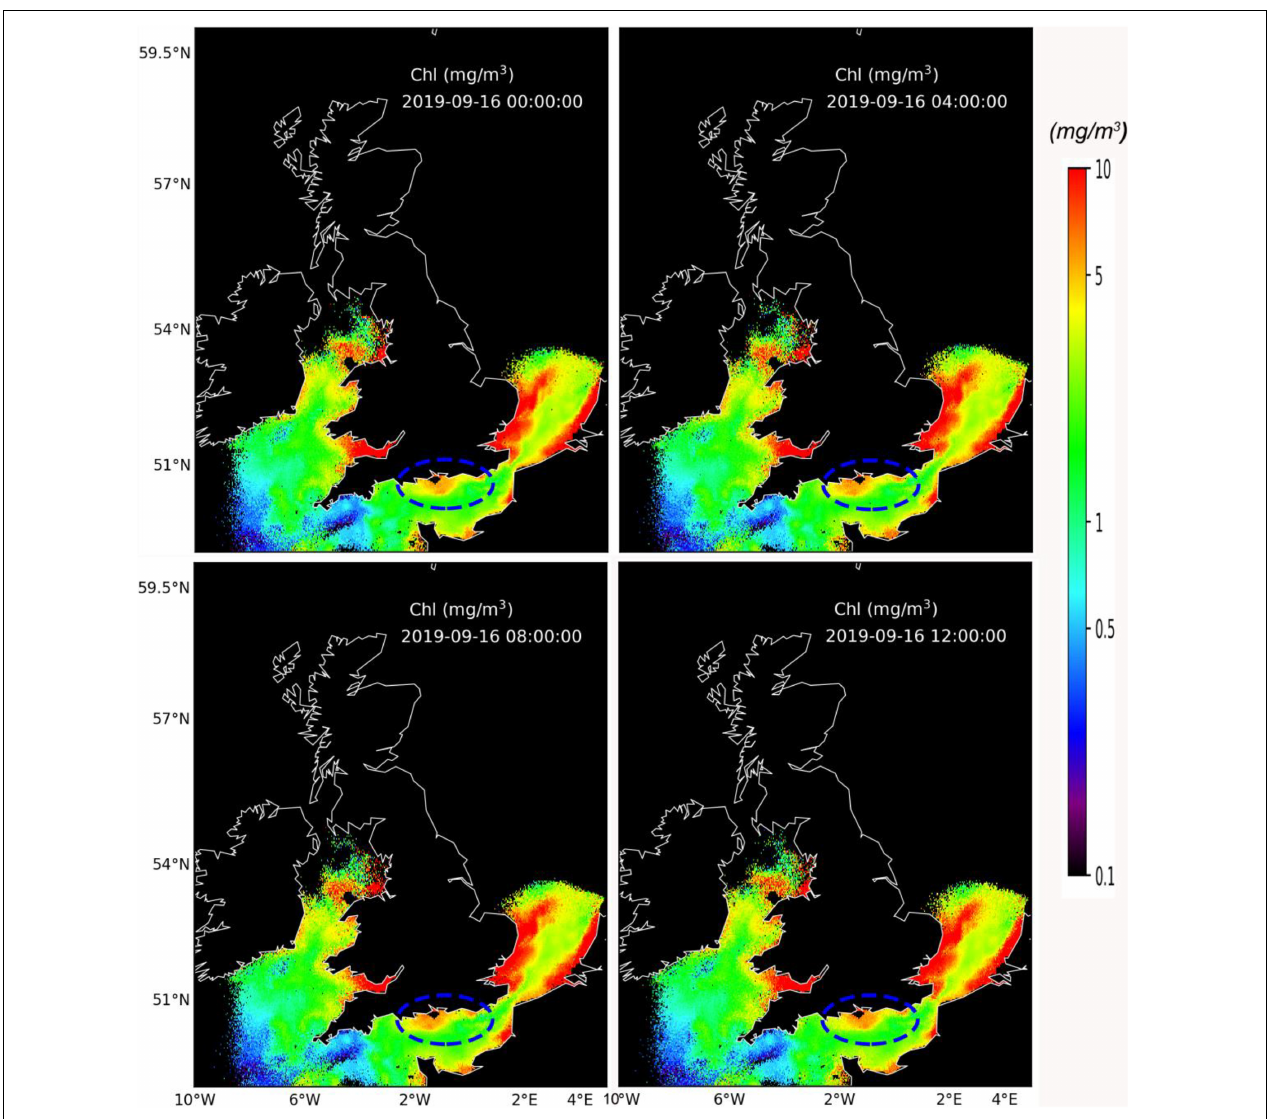
FIGURE 4 | Frames of predicted Chl distribution at 4-h intervals during the first forecast day (September 16, 2019). The dashed ellipse is in the same location in each frame, highlighting the movement of a bloom along the south coast of England. The animation of the complete 2-day forecast can be found via